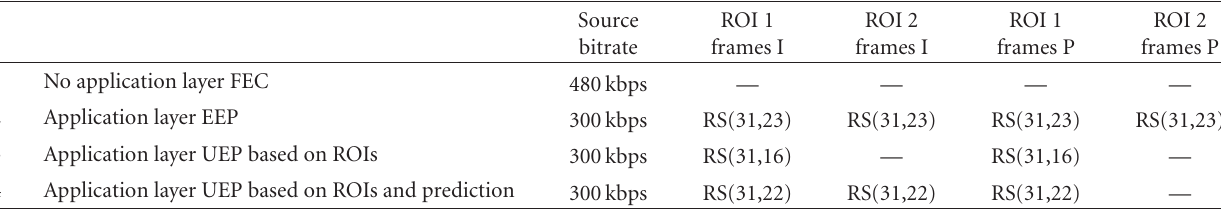
Table 6: Application-layer unequal error protection strategies adopted.